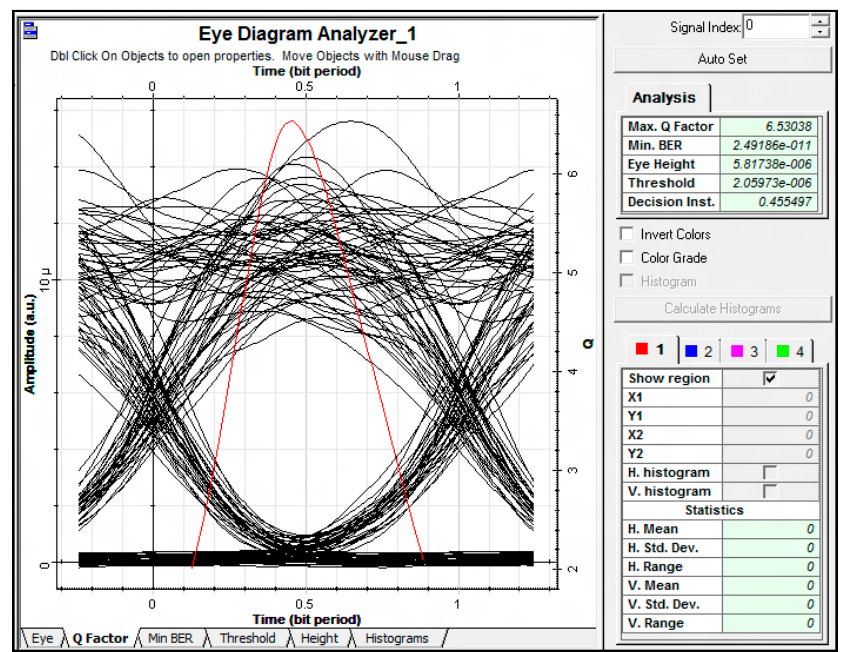
Figure 5. Eye diagram for one user of SAC-OCDMA system using EDW code and APD photodetector at 622 Mbps and 100 km.